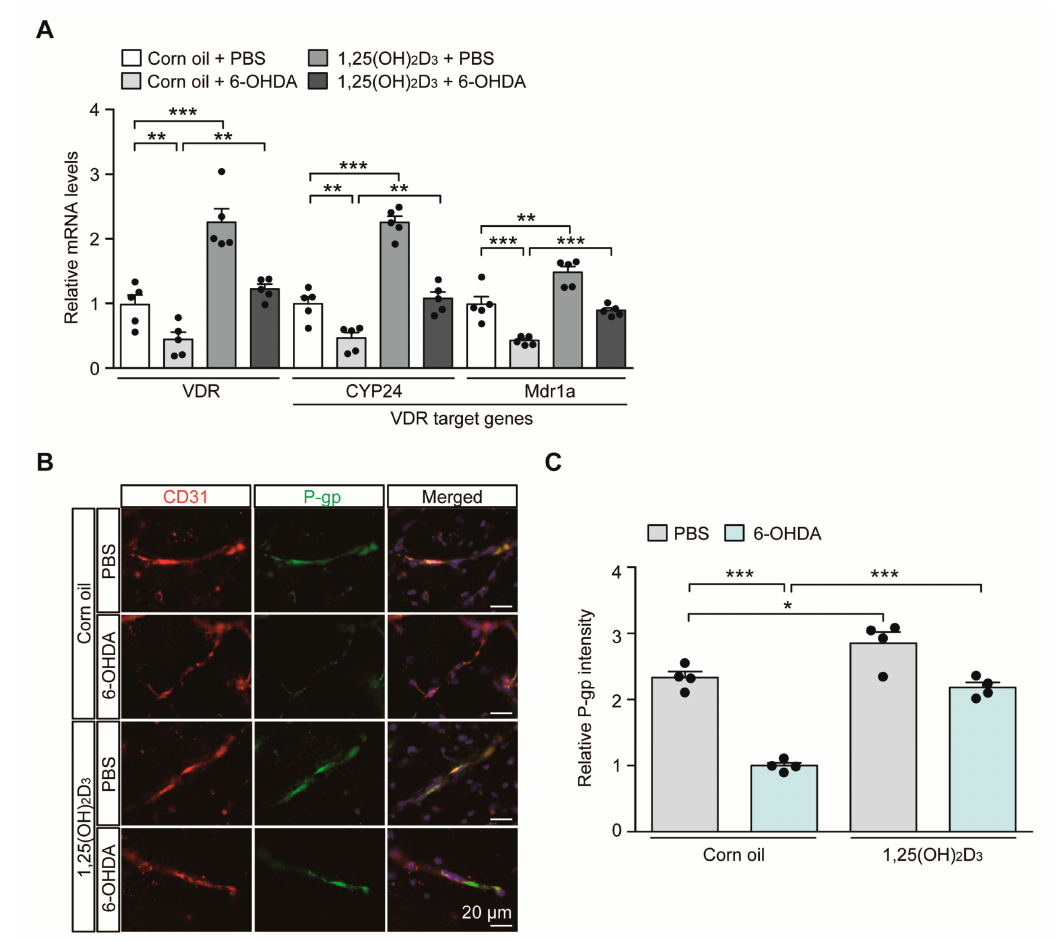
Figure 2. Transcriptional VDR repression and endothelial P-glycoprotein (P-gp) protein downregulation in 6-OHDA PD mice are reversed by 1,25(OH)2D3 treatment. ( A ) Quantification of relative mRNA expression of VDR and its target genes CYP24 and MDR1a in the ventral midbrain tissues from each experimental mouse group determined using qRT-PCR and normalized to internal loading control GAPDH ( n = 5 mice per group). ( B ) Representative immunofluorescence of P-gp and CD31 in the ventral midbrain sections from each experimental mouse group. CD31 serves as a marker for endothelial cells. Scale bar = 20 µ m. ( C ) Quantification of P-gp immunofluorescence signal intensities in CD31-positive endothelial cells from the SNpc regions from each mouse group ( n = 4 mice per group). Data are expressed as mean ± SEM. * p < 0.05, ** p < 0.01, and *** p < 0.001, ANOVA test, followed by Tukey’s post hoc